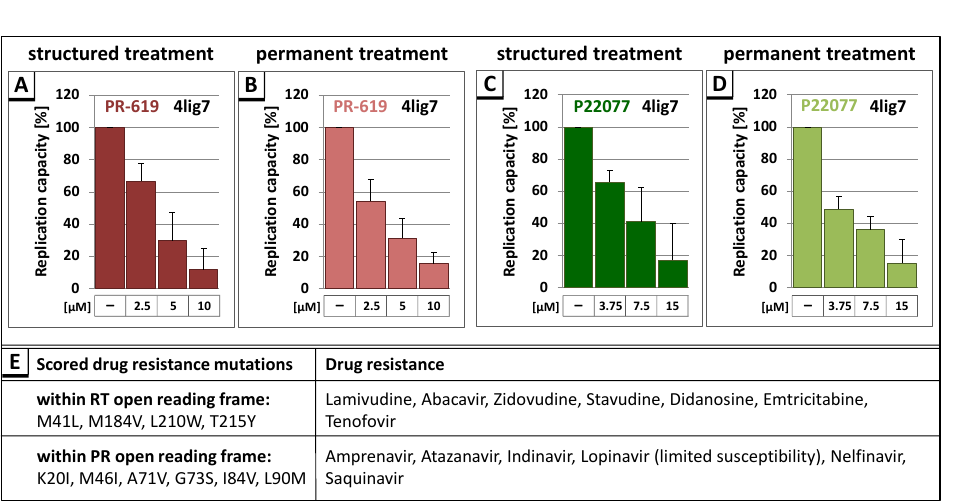
Figure 6. ( A , B , C , D ) Treatment with PR-619 and P22077 reduces the replication capacity of the multidrug resistant field isolate HIV-1 4lig7 . Following infection of HLAC with HIV-1 4lig7 (0.5 ng p24), structured and permanent treatment with 2.5 μM, 5 μM, or 10 μM PR-619 or 3.75 μM, 7.5 μM, or 15 μM P22077 respectively, was performed. Cell culture supernatant was collected on the indicated days post infection (see Figure 4). The replication capacity of HIV-1 4lig7 was assessed by calculating the AUC of each individual replication profile. The replication capacity of untreated HIV-1 4lig7 in each experiment was set to 100%. Bars represent the mean values of 3 independent experiments ± SD; ( E ) Scored drug resistance mutations within the RT and the PR open reading frame and corresponding drug resistances.